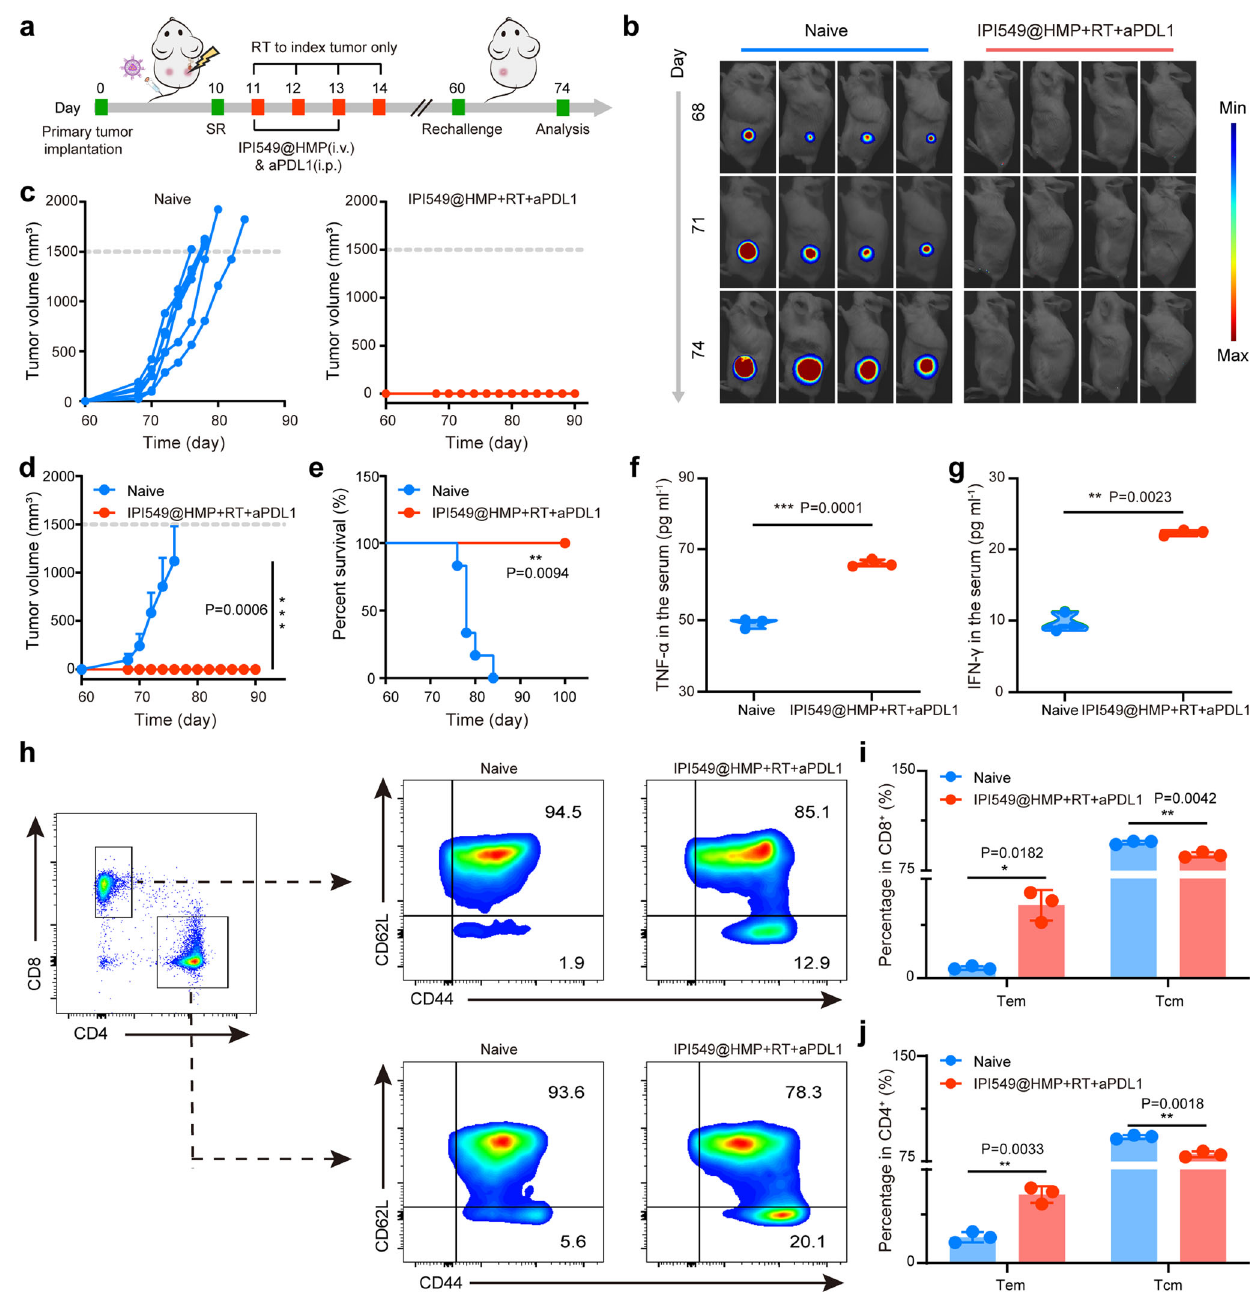
Fig. 8 Long-term immune memory effects. a Schematic illustration of the experiment design to assess the immunological memory response triggered by IPI549@HMP-augmented RT and anti-PD-L1 combination therapy. b Representative bioluminescence images of Luc + CT26 tumor of six biologically independent animals from each group after varied treatments as indicated. c – e Individual ( c ), average ( d ) tumor growth curves and survival curves ( e ) of the treated mice. Error bars are based on means ± SD ( n = 6 mice in c – e ). f , g Cytokine levels of TNF- α ( f ) and IFN- γ ( g ) in the serum after